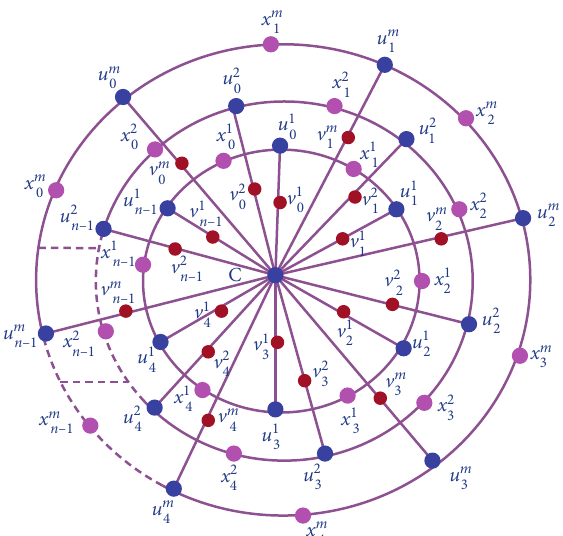
Figure 2: Uniform subdivision of multiwheel graph mS